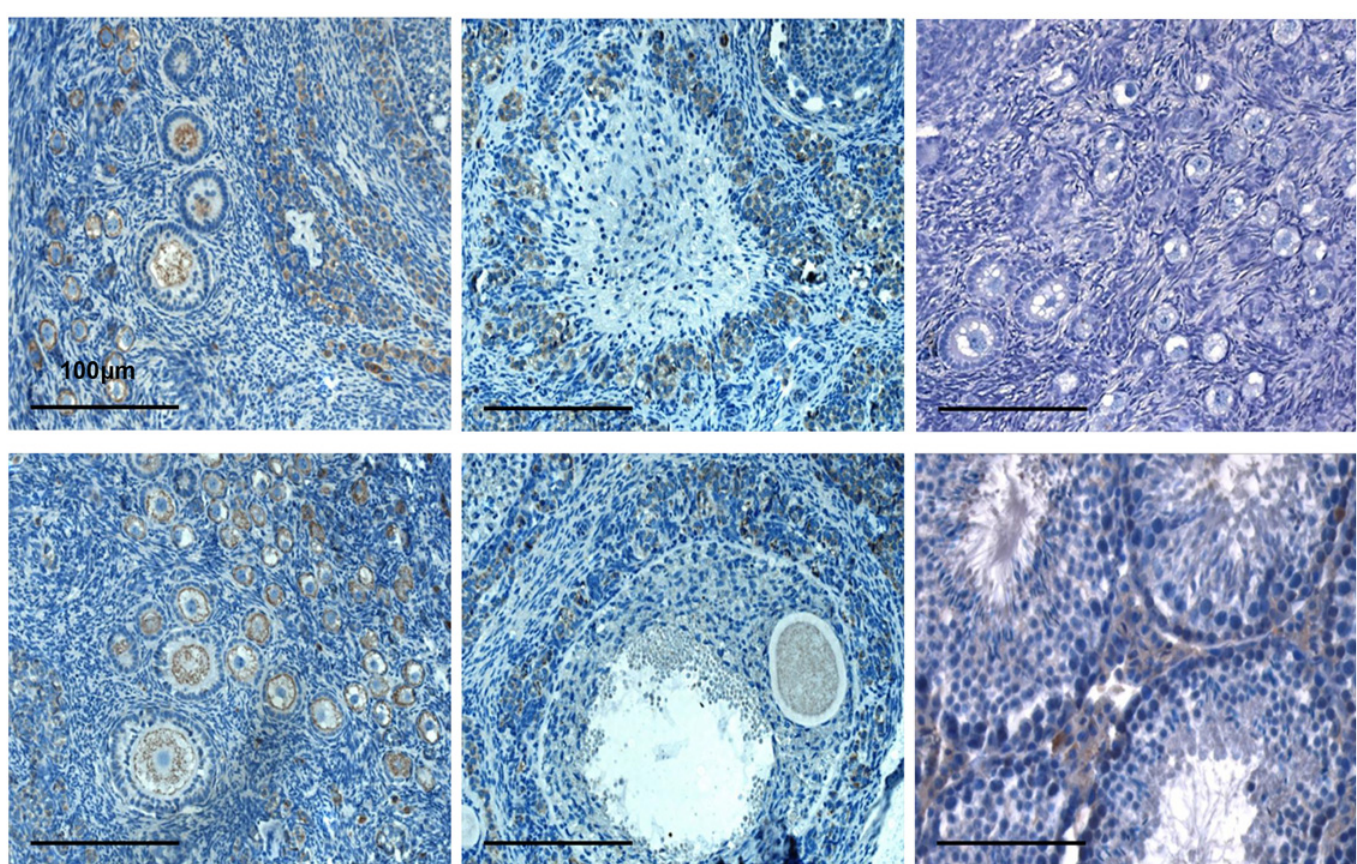
Fig 3. Immunohistochemical staining for BMP15 in the rabbit ovaries of the mothers and F1- female offspring generations. Localization of the protein BMP15 in: (a) oocytes of the primordial and primary follicles in the VHT-treated mothers ovary; (b) granulosa cells of the tertiary follicle in the VHT- treated mothers ovary; (c) primordial and primary follicles — negative control of antibody; (d) oocytes of primordial and primary follicles in the ovary of F1 offspring born to treated mothers; (e) oocytes and granulosa cells of the antral follicle in the ovary of F1 offspring born to treated mothers; (f) mouse testis — positive control of antibody; (g) Original magnification: (a – f) ×